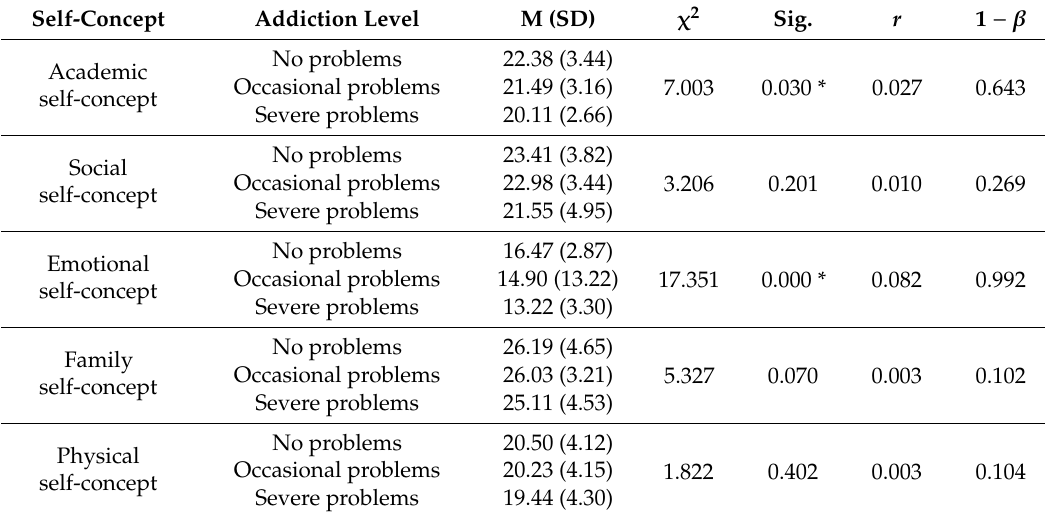
Table 4. H Kruskall Wallis test between self-concept and mobile